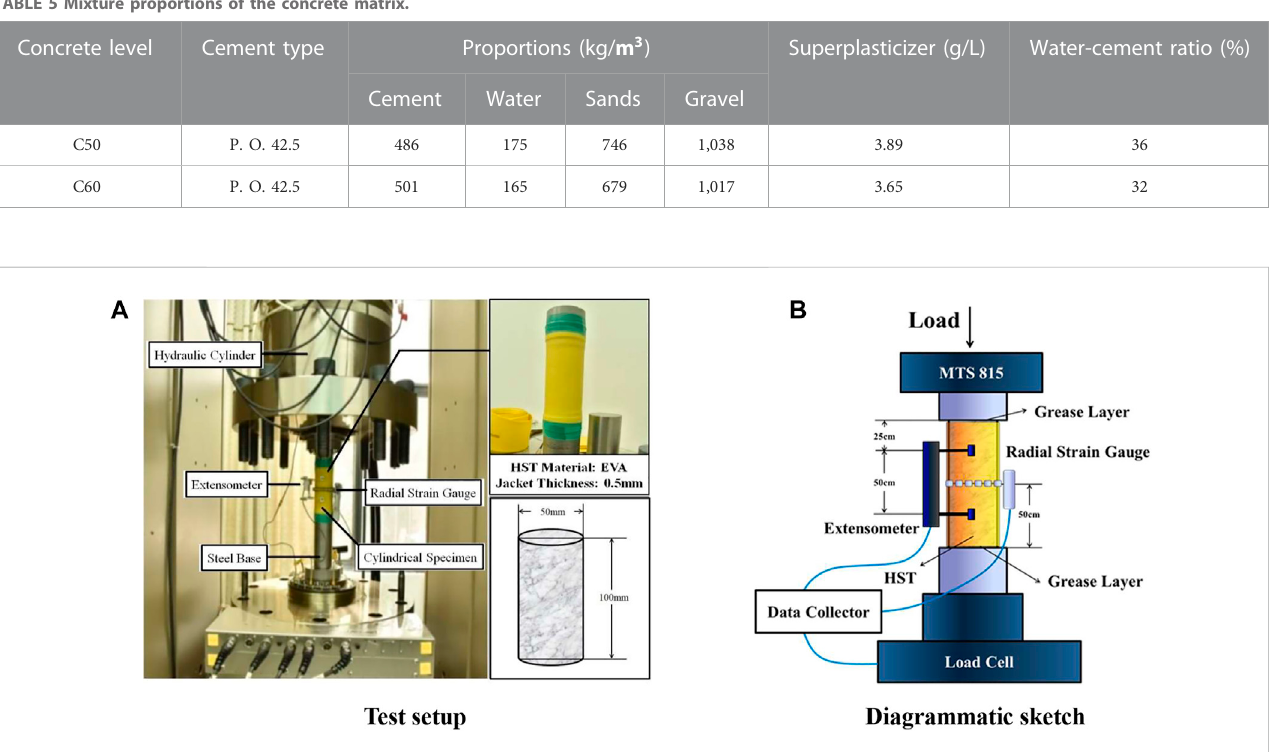
FIGURE 3 Installation of the cylinder HFRC specimen. (A) Test setup. (B) Diagrammatic